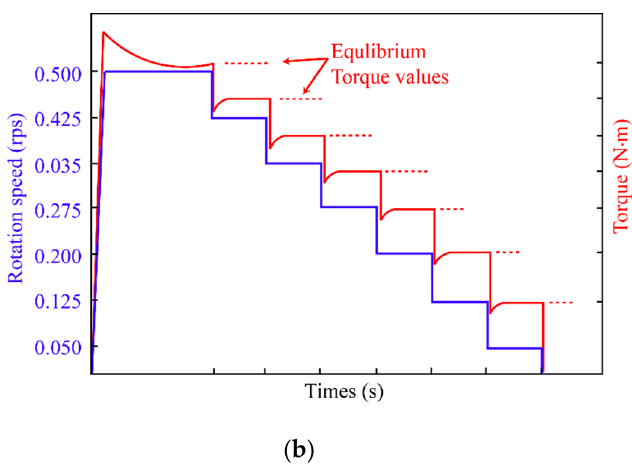
Figure 2. ( a ) Concentric cylinder structure of rheometer. ( b ) Test system of rheological parameter.